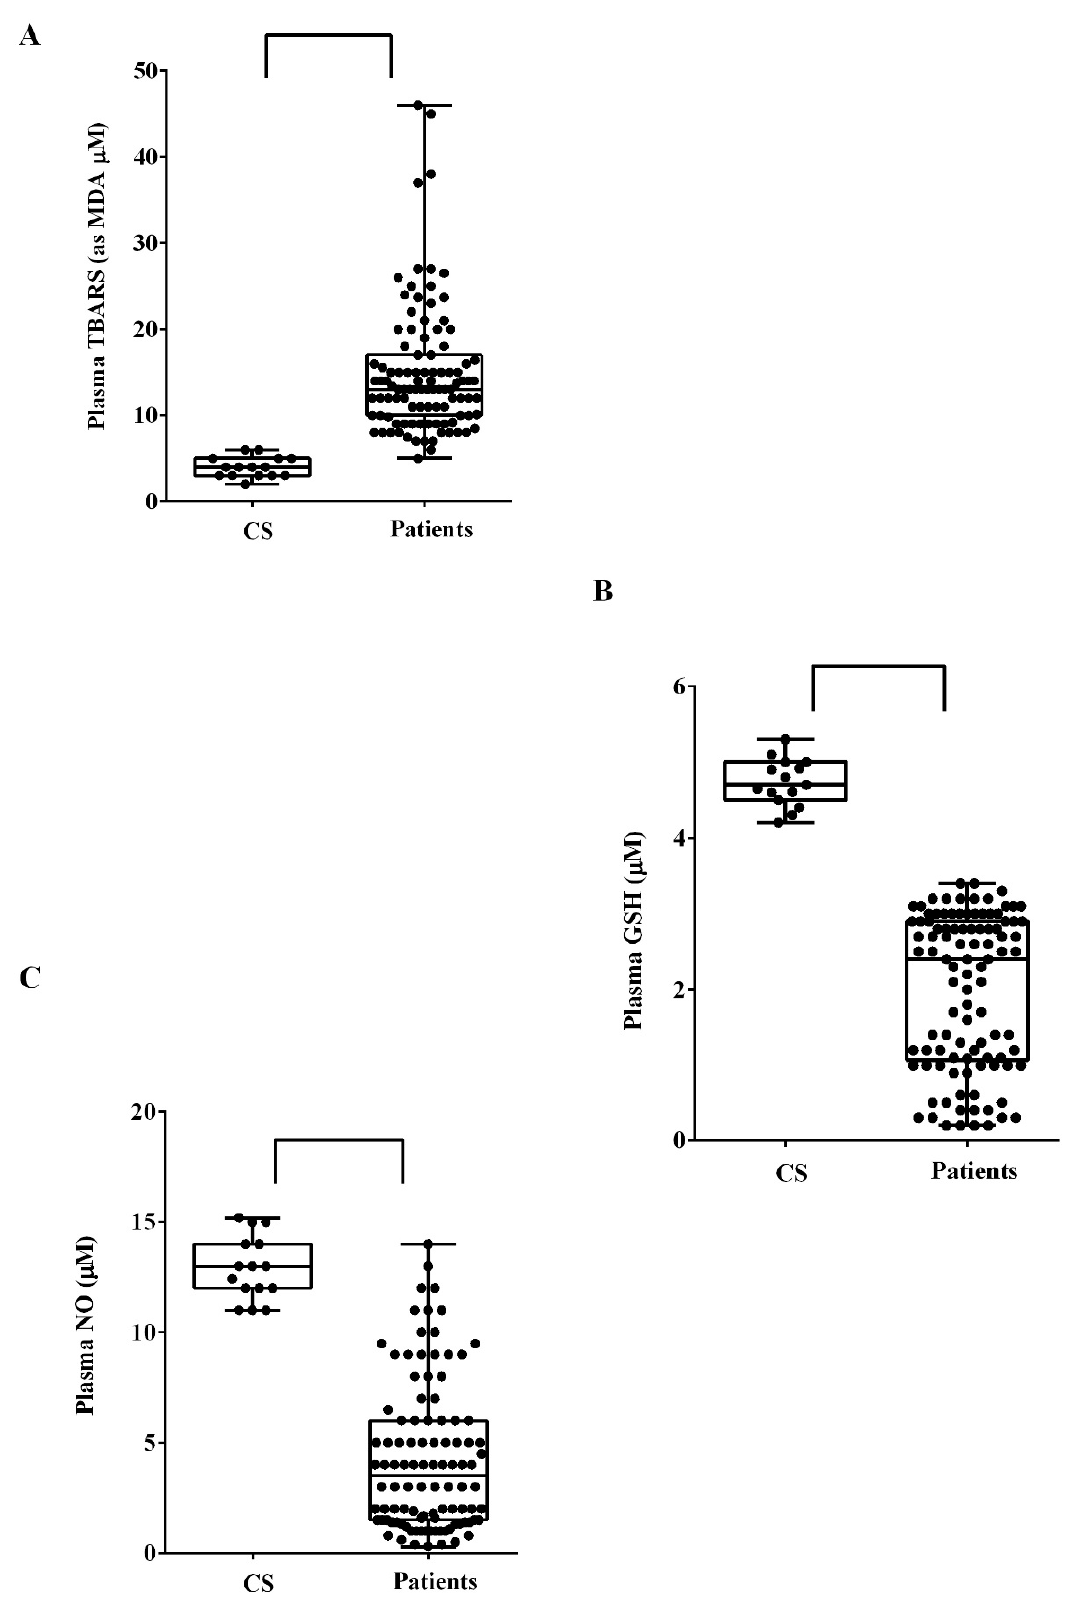
Figure 2. Plasma TBARS ( A ), GSH ( B ) and NO ( C ) levels in ALS patients. CS: control samples. GSH: glutathione; MDA: malonyldialdeide. NO: nitric oxide. Square brackets indicate significance between groups as p < 0.05.